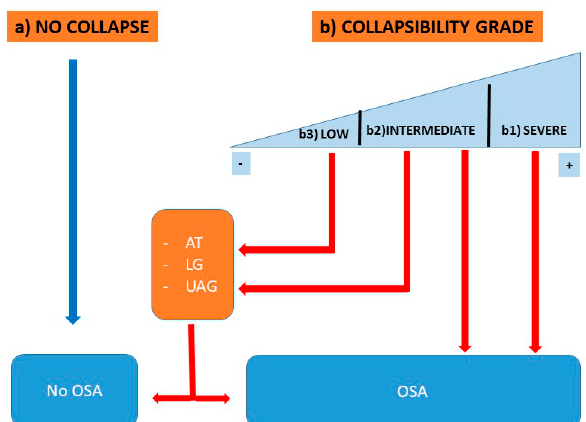
Figure 1. Relationship between UA Collapsibility and other PTs. Patient ( a ) has no UA collapse and does not develop OSA, even if the other PTs are impaired. Patient ( b1 ) has a severe UA collapsibility and develops OSA even if the other PTs are normal. Patient ( b2 ) has an intermediate level of UA collapsibility. Patient ( b3 ) has a mild degree of UA collapsibility and develops OSA only if the other PTs are significantly impaired. Legend: AT: arousal threshold; LG: loop gain; UAG: upper airway gain; OSA: obstructive sleep apnea.